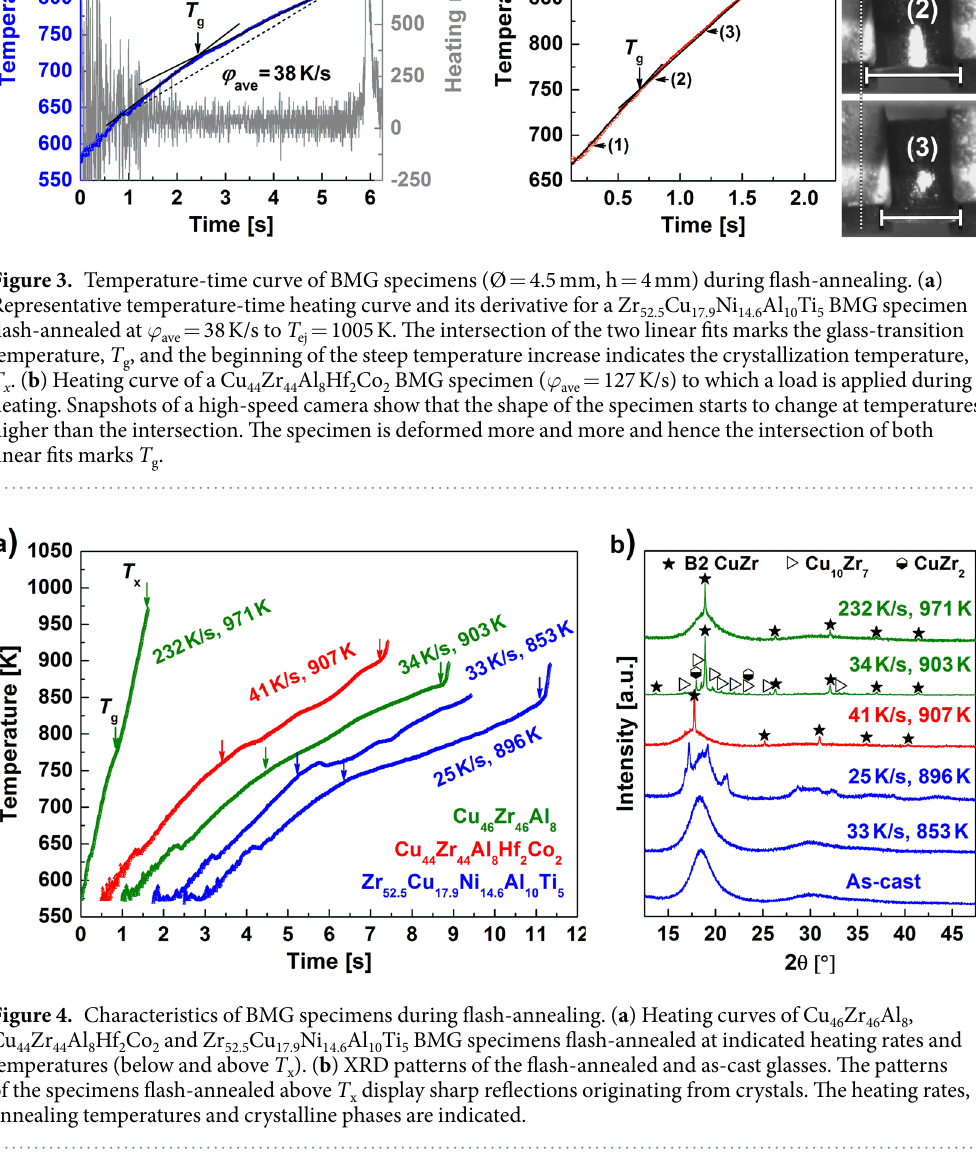
suffices to plastically deform the sample. The camera monitors the shape change during flash-annealing and syn- chronization of the camera with the pyrometer allows correlating the images with the corresponding temperature. Figure 3b shows the typical heating curve of a Cu 44 Zr 44 Al 8 Hf 2 Co 2 BMG specimen ( ϕ ave = 128 K/s, T ej = 1031 K). Also here the two slopes become evident. Snapshots before and after the intersection of the two linear fits (Fig. 3b) reveal that the sample begins to be plastically deformed just above the intersection temperature. Consequently, the slight decrease of the slope in the T - t curve originates from the glass transition. This furthermore demon- strates that the present setup is in general also suitable for thermoplastically forming BMGs and could be used to modify the surface or the entire sample shape in a fast process with a high throughput. To simplify the subsequent discussion, only an average heating rate, ϕ ave , is considered for all flash-annealing experiments. After the glass-transition temperature is traversed, continued heating gives rise to a steep temper- ature increase (Fig. 3a). It is attributed to recalescence and the temperature at the beginning of it then indicates the crystallization onset temperature, T x ( = 826 K) (Fig. 3a): The X-ray diffraction (XRD) pattern of amorphous Zr 52.5 Cu 17.9 Ni 14.6 Al 10 Ti 5 heated to temperatures below this steep increase (Fig. 4: T ej = 853 K) only shows a broad